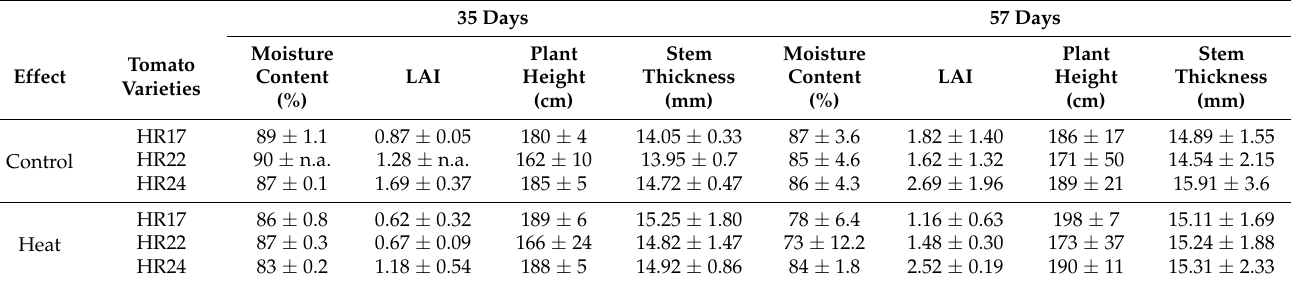
Table 3. Effects of long-term heat treatment on moisture content, leaf area index (LAI), plant height, and stem thickness of three cherry tomato accessions, in HR17, HR22, and HR24, grown in two different time periods, 35 days and 57 days, in heat-treated and control greenhouses. n.a. data are not available.